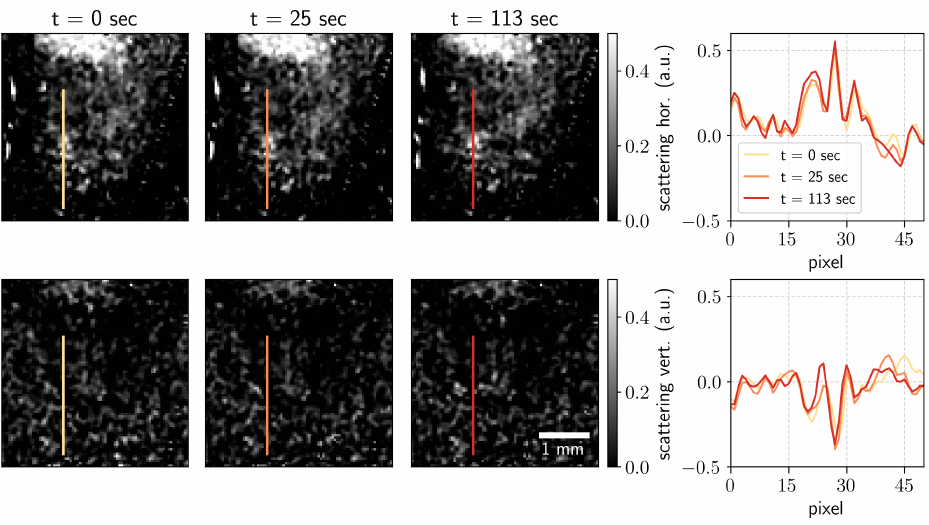
Figure 4. Scattering contrast images in two orthogonal directions for the measurement time t = 0, 25, and 113 s and the corresponding profiles along the indicated